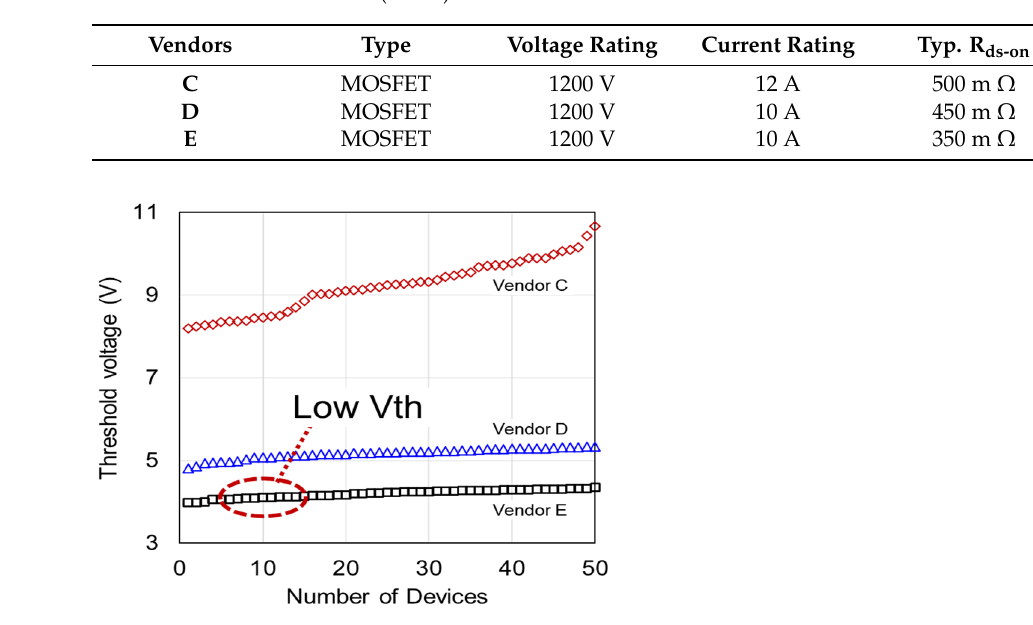
Figure 2. Threshold voltage variation of 50 SiC MOSFETs from each vendor. The variation of threshold voltage with temperature is shown in Figure 3. The data vendors. It can be observed that the threshold voltage reduces as temperature